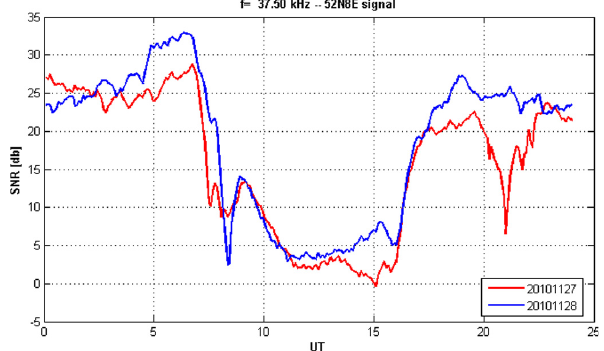
Fig. 2. Forcing from above: subauroral particle precipitation dur- ing nighttime (red: 27 November 2010) cp. to (blue: 28 November 2010). Path: NRK, Iceland – 52 ◦ N 8 ◦